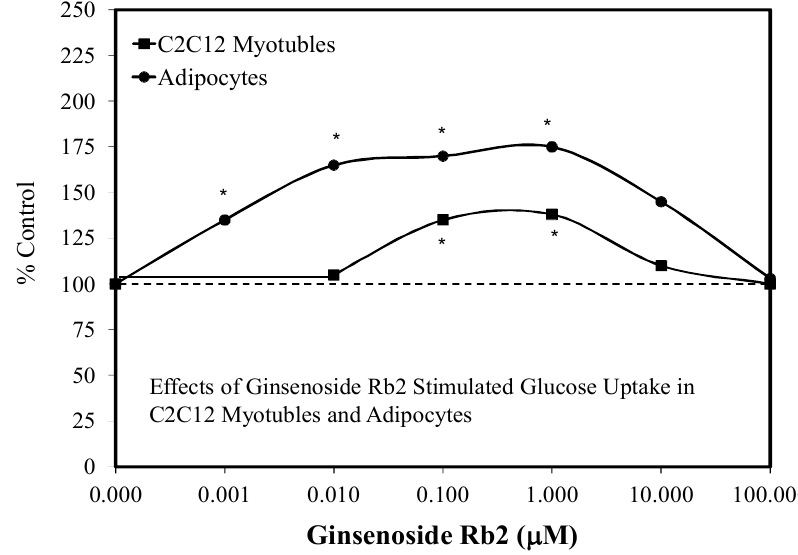
Figure 19. Effects of ginsenoside Rb2 stimulated glucose uptake in C2C12 myotubles and adipocytes (source: [83]). Each * represent statistical significance for a data point.